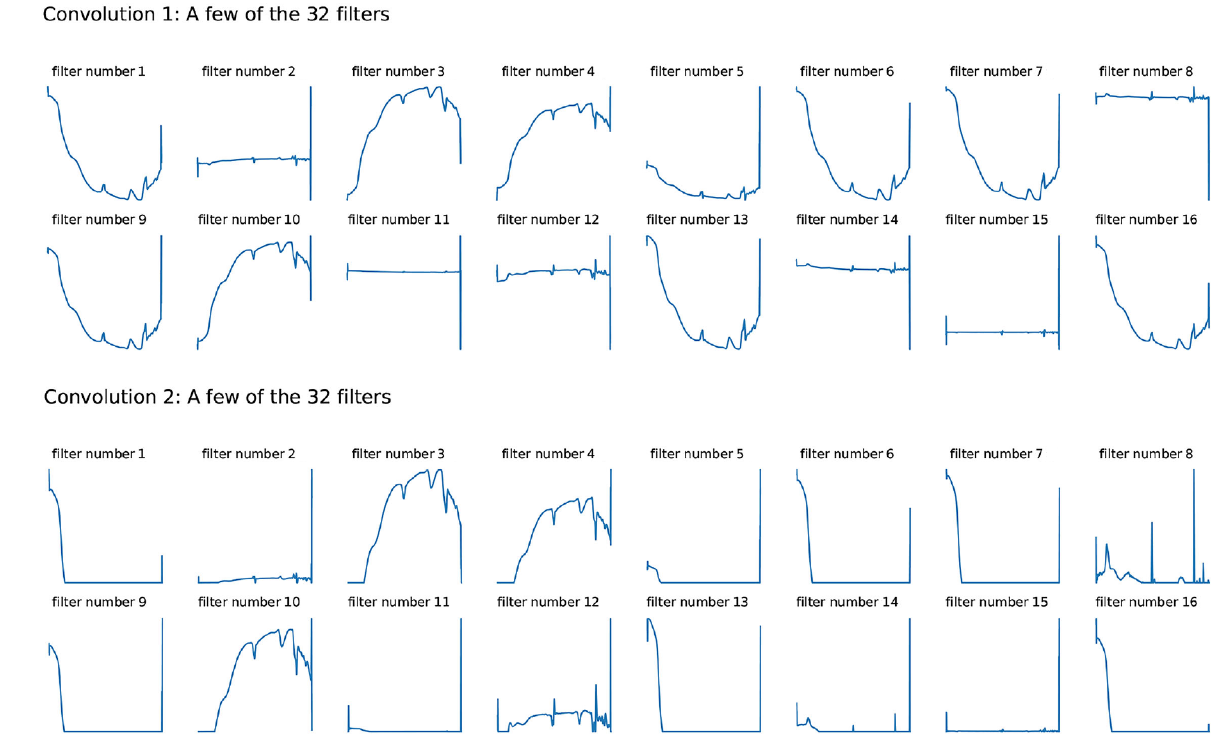
Figure 5. Visualisation of the filters in the first two convolutional layers within the 1D convolutional neural network (CNN) model of the visible, near and shortwave infrared (VIS–NIR–SWIR) spectra.